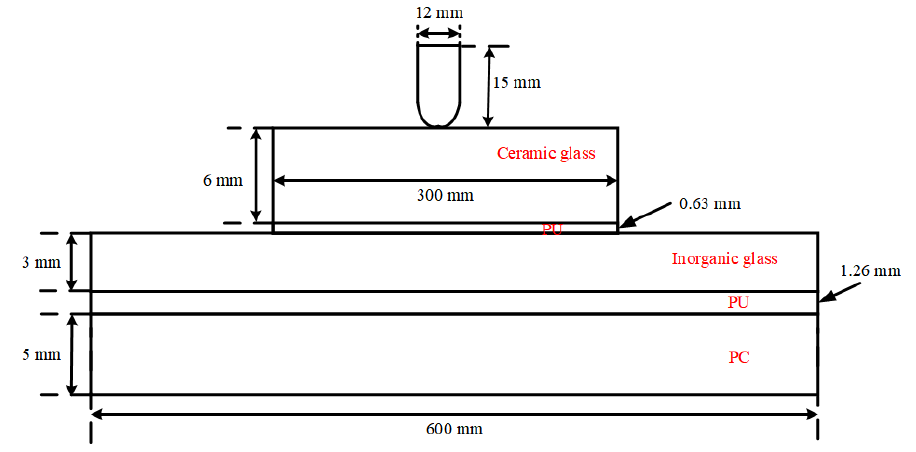
Figure 3. The geometry of the transparent sandwich structure.